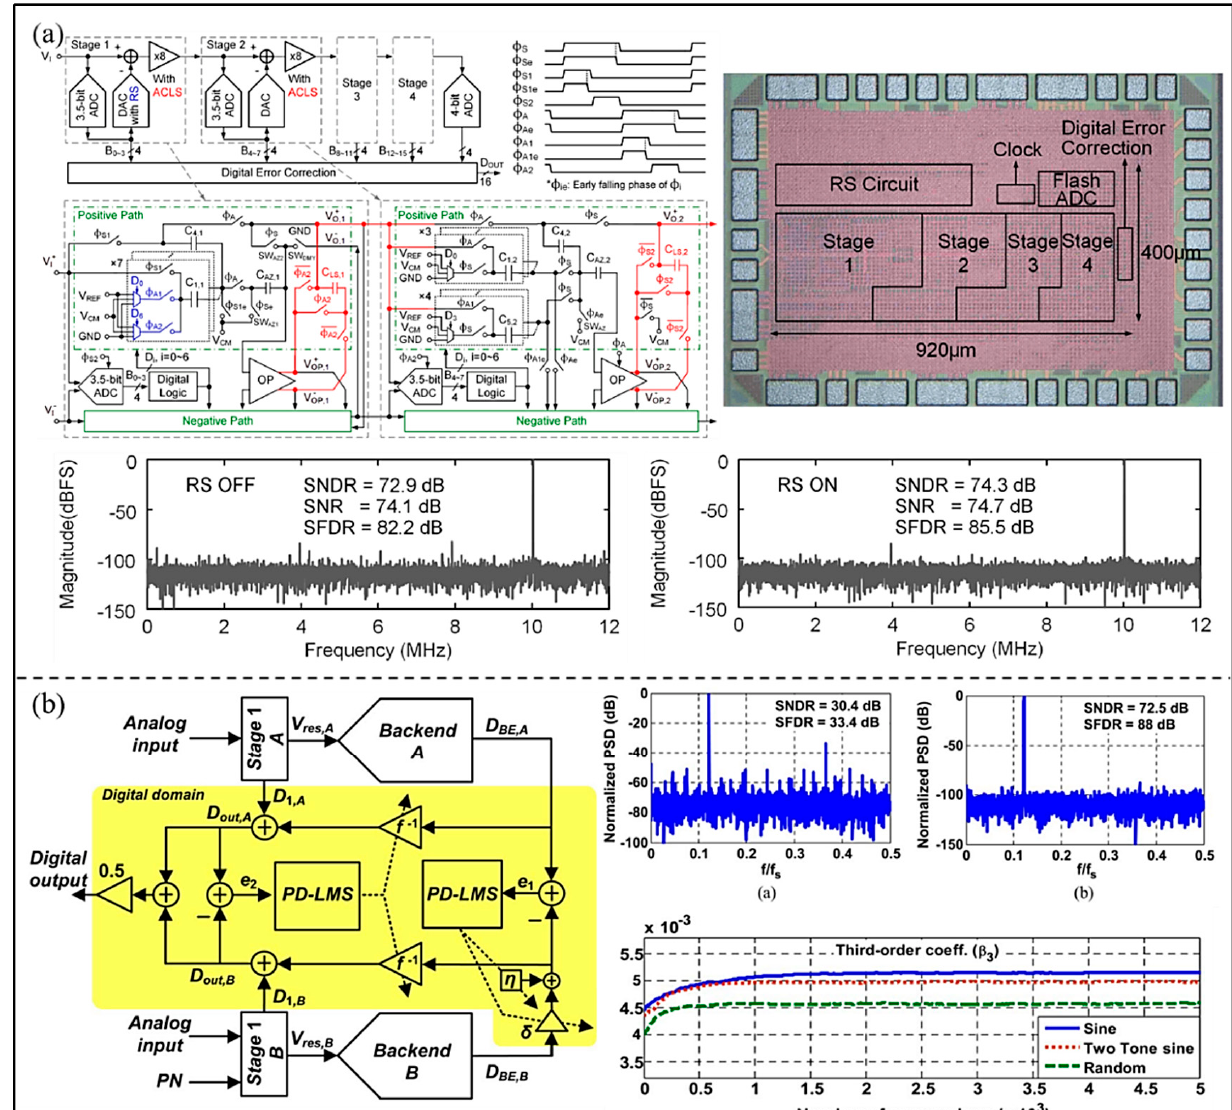
Figure 15. ( a ) Circuit architecture, chip micrograph, and measured spectra of the proposed ADC.